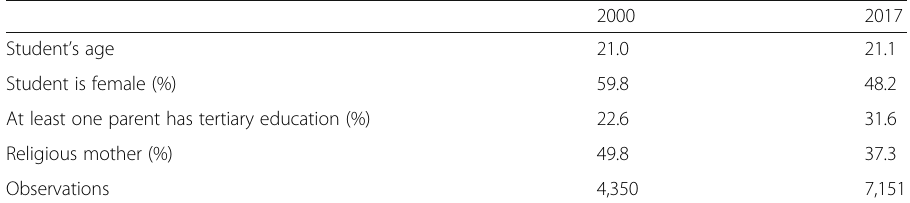
Table 3 Control